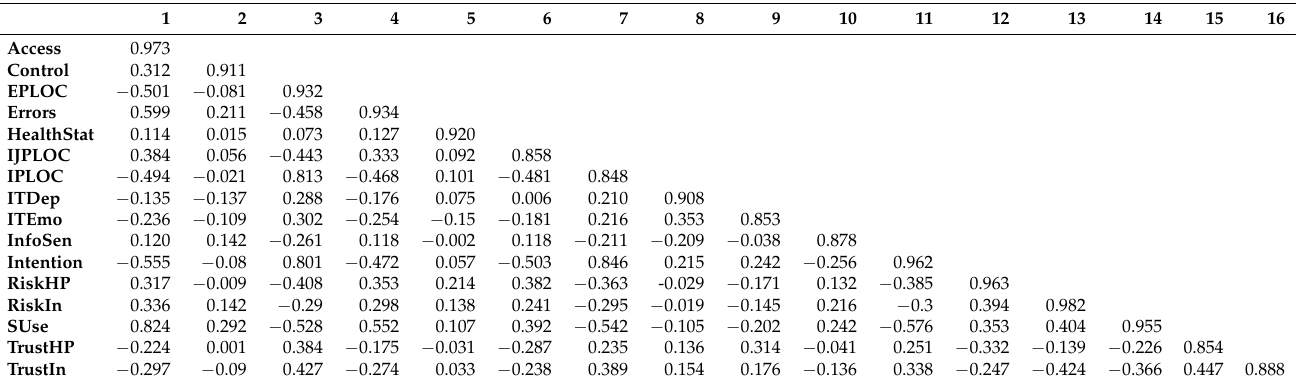
Table A9. Fornell–Larcker Criterion for Discriminant Validity of Multi-Item